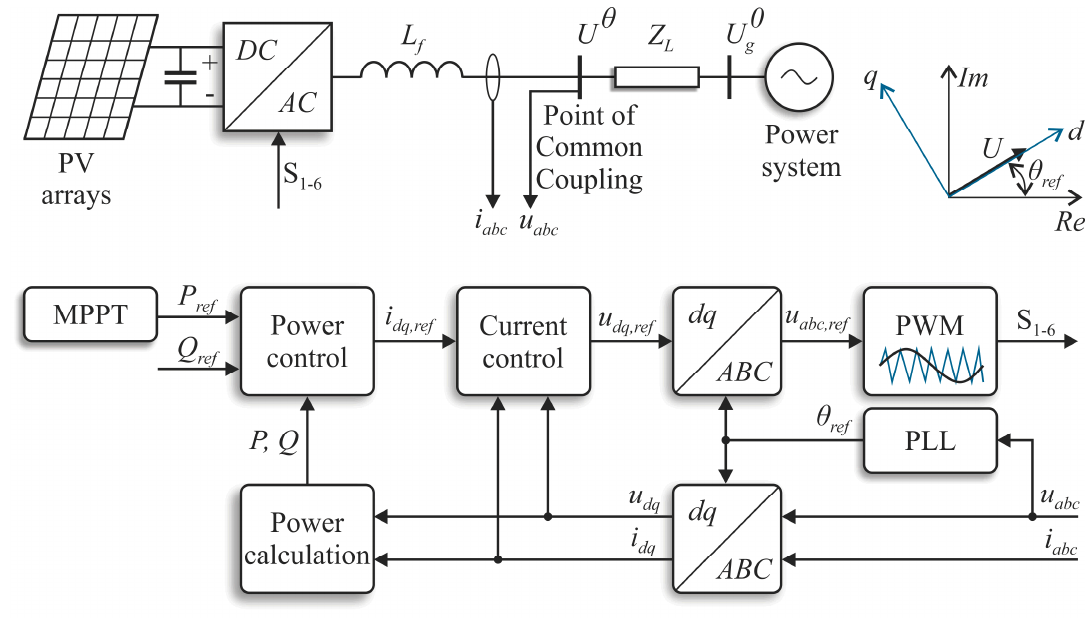
Figure 1. Control of grid-connected inverter.